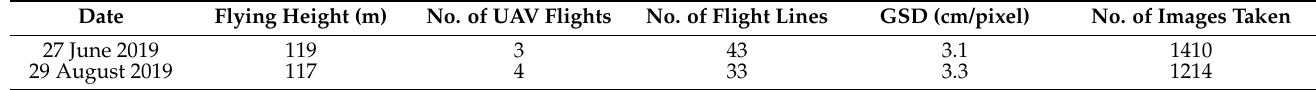
Table 1. Characteristics of the UAV flight missions.